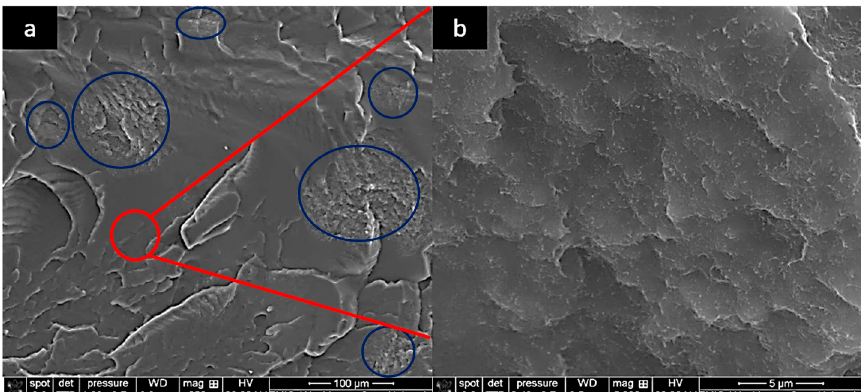
Figure 1. SEM micrograph of TPU-1 vol% MWCNT composite with two different magnifications: ( a ) showing the MWCNT-rich areas identified by blue circles and ( b ) a magnified MWCNT-poor area, showing the dispersion of individual MWCNTs (the white speckles are individual MWCNT).